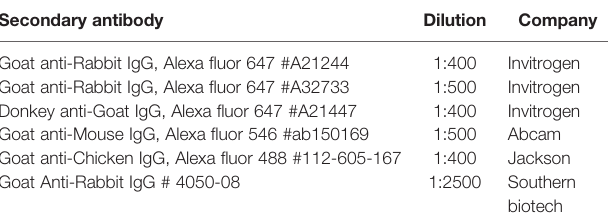
TABLE 4 | The product information and dilution of secondary antibodies used to detect the various target epitopes in this study. Secondary antibody Dilution